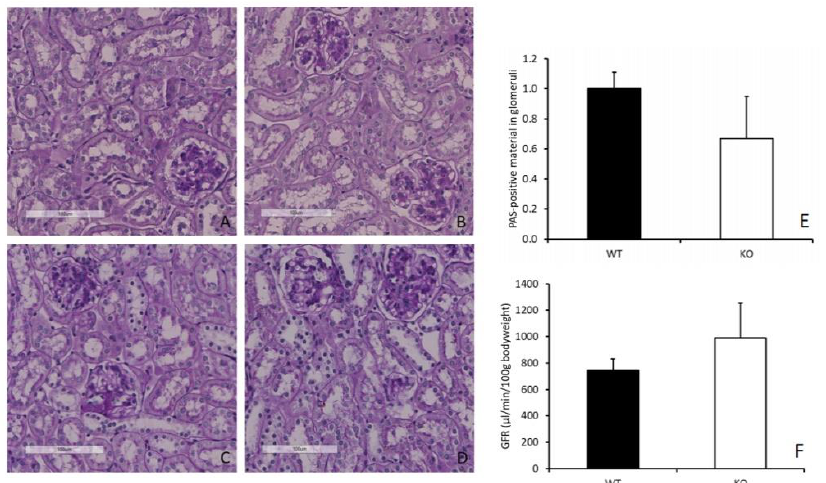
Figure 4. Kidney morphology and function was similar in 55-week-old Cndp1 -KO and WT mice. Representative kidney specimens of male ( A ) and female ( B ) Cndp1 -KO mice and male ( C ) and female ( D ) WT mice with PAS reaction showed no alterations. Deposition of PAS positive material in glomeruli of Cndp1 -KO ( n = 4) and WT mice ( n = 4) was not different ( E ). Glomerular filtration rate (GFR) was also unaltered in Cndp1 -KO mice ( n = 11) compared to age-matched WT mice ( n = 4) ( F ).